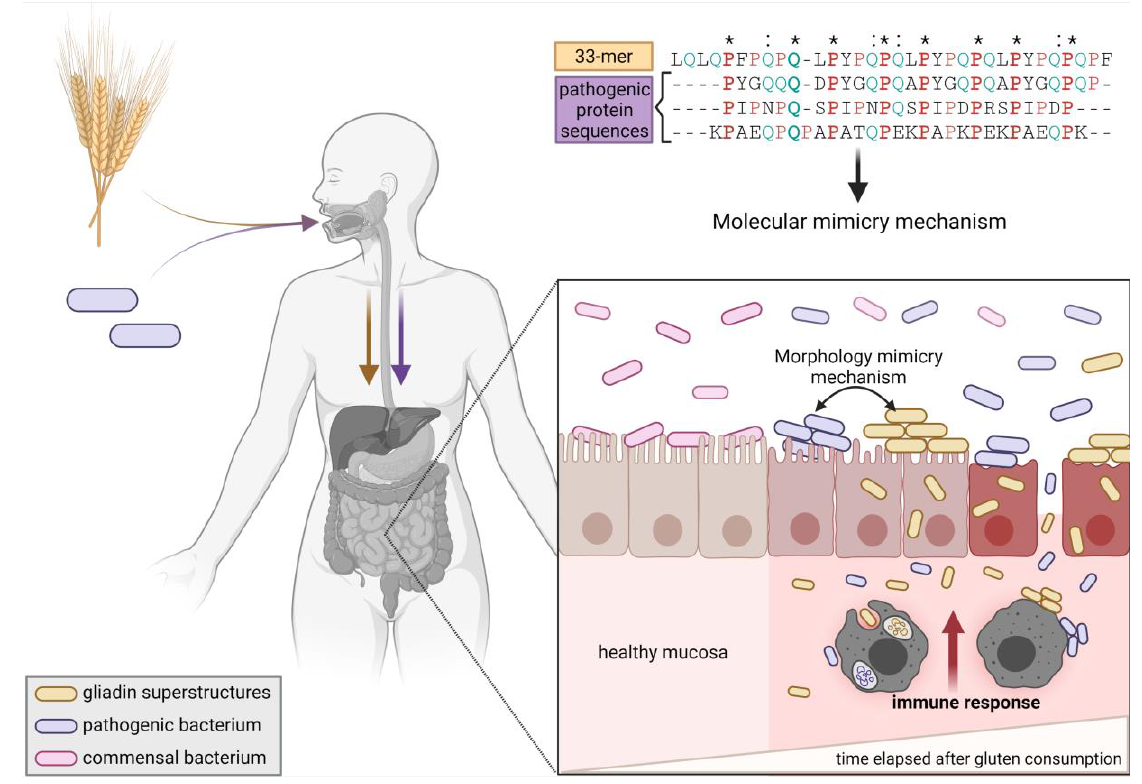
Figure 1. Cartoon summarizing the results and hypothesis presented here. Gluten peptides and pathogens can both enter the intestinal lumen through oral intake. Based on this work, gluten peptides share high sequence, structural and morphological similarities with different proteins found in bacterial pathogens. Some of them share putative T-cell epitopes related to celiac disease (CeD),reinforcingtheideaofmolecularmimicryasthetriggerofCeD(conservedaminoacidsinthe33-mersequenceandthebacterial proteins are shown (*)). On the other side, a new concept of morphology mimicry is presented, where the immune cells recognize gluten superstructures as bacterial pathogens because of their similar morphology, starting an innate immune response. Exposure to most pathogens and gluten is necessary but not sufficient to cause disease because the genetic background and susceptibility, and dose effects, are additional determinants for disease progression (Created with biorender.com, accessed on 23.08.21, under academic license